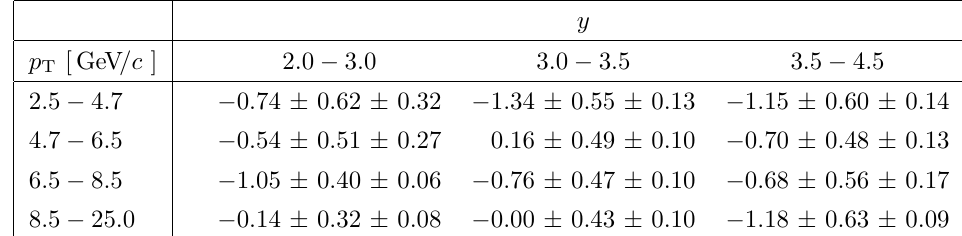
Table 3 . Values of the D + and systematic uncertainty for each of the D +